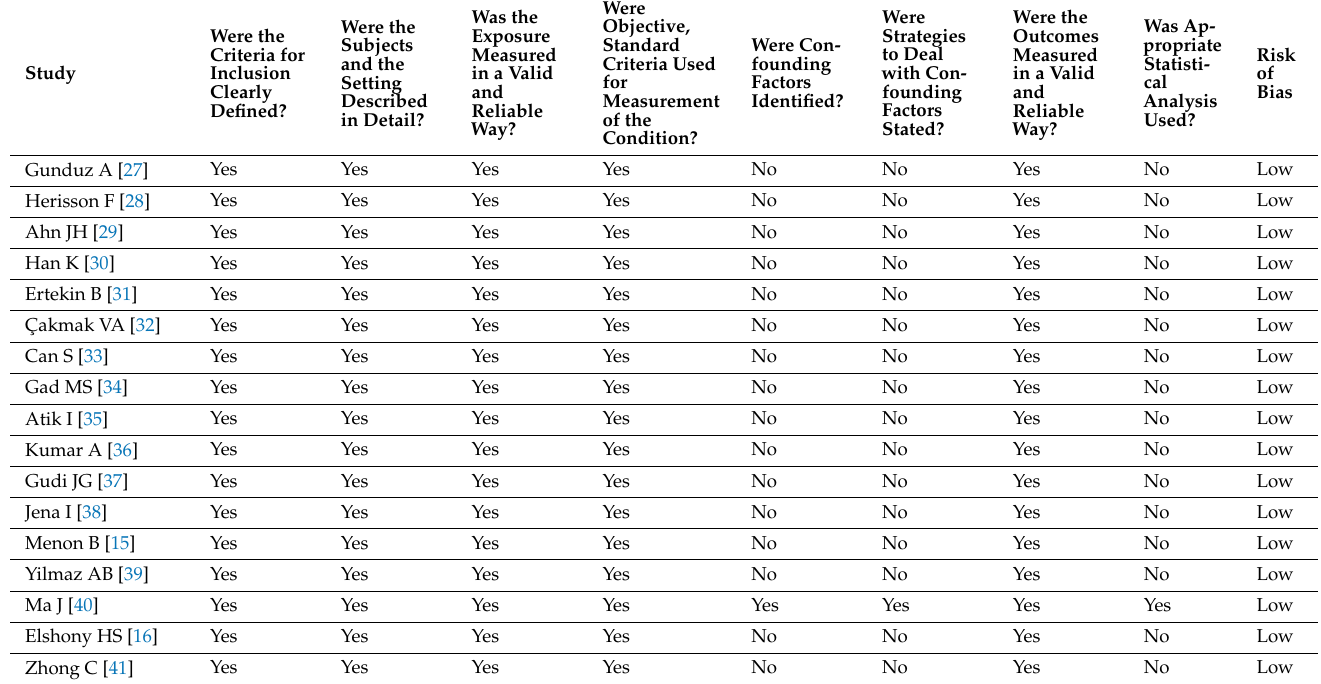
Table 2. The Joanna Briggs Institute critical appraisal checklist.